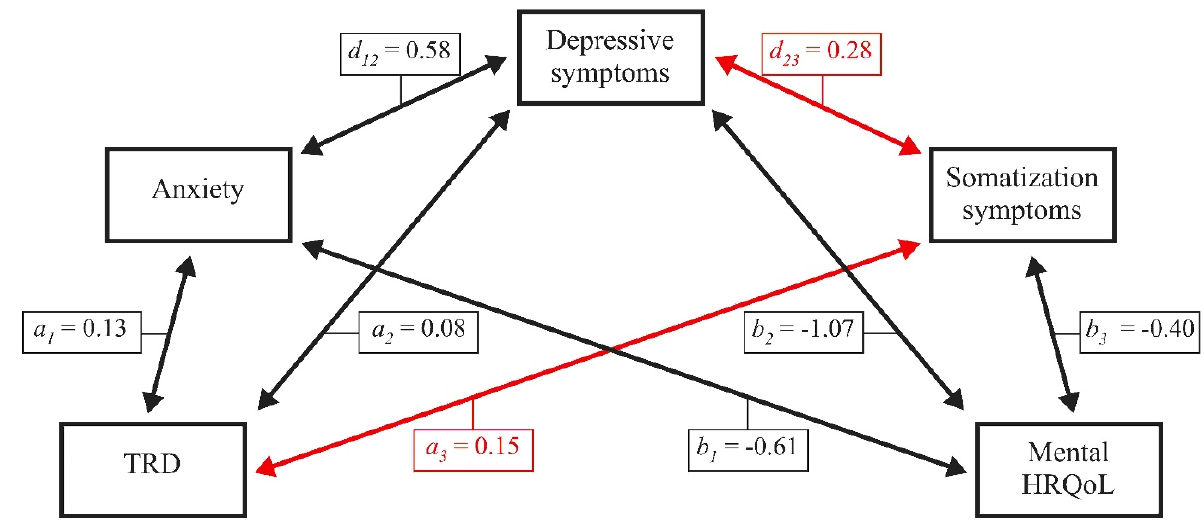
Figure 1. Anxiety, depressive symptoms, and somatization symptoms completely mediate the effect of TRD on mental HRQoL in female patients with chronic tinnitus. TRD = tinnitus-related distress; HRQoL = health-related quality of life. Numbers indicate unstandardized multiple regression coefficients. Red lines indicate effects that are significant in female patients only.